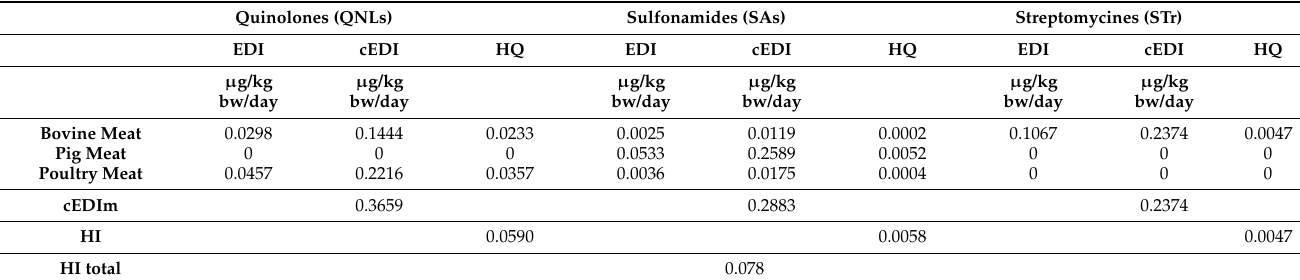
Table 5. Estimation of the corrected exposure (cEDI) and hazard quotients (HQs) by ELISA detected levels, ADIs and calculated CFs